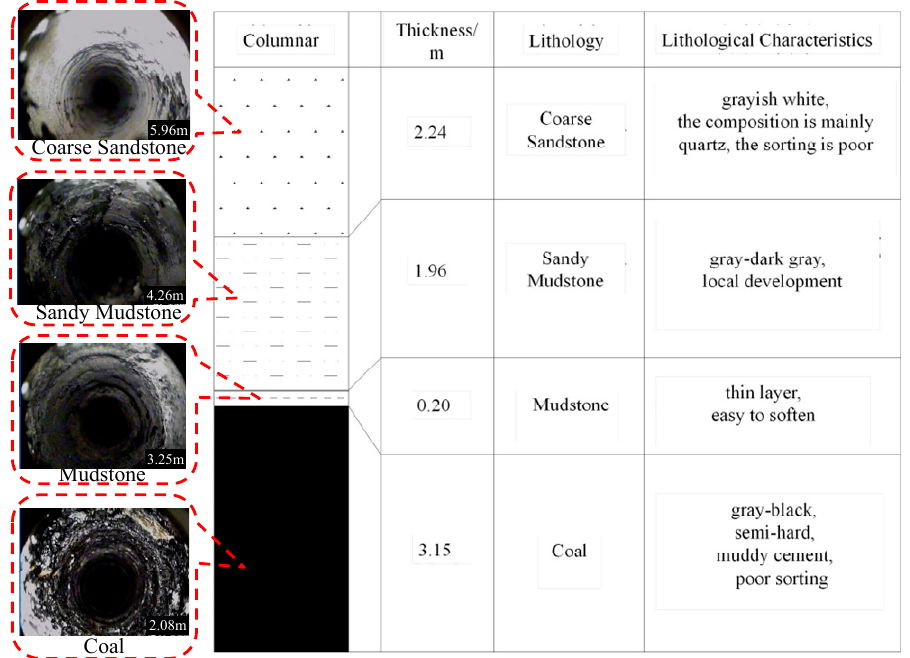
Figure 2. Roof strata structure of the panel 81305 No.2 return airway.